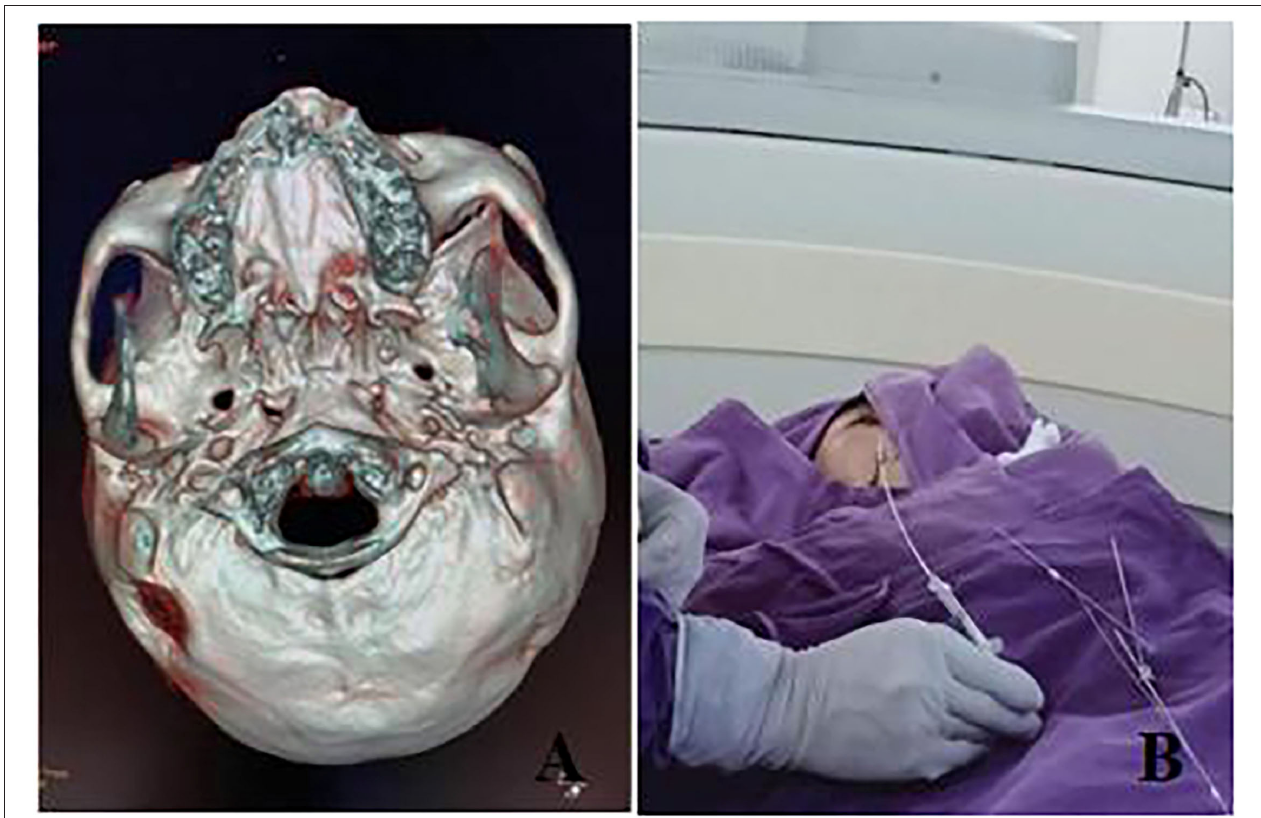
FIGURE 1 | (A) 64-slice CT skull reconstruction was performed before surgery to check the direction and size of the foramen ovale; (B) Determine the direction of the patient’s puncture.